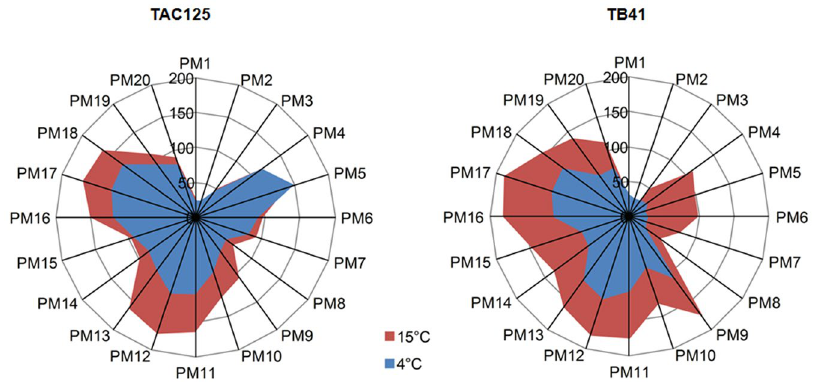
Figure 2. Phenotype Microarray (PM) experiment. Radar plots representing the number of the different growth phenotypes of the PhTAC125 and PspTB41 strains as assessed by the PM experiment at 4 °C (blue) and 15 °C (red). Each radial strip corresponds to a single PM microplate (PM1-20). PM categories: Carbon Sources (PM1, PM2), Nitrogen Sources (PM3), Phosphorus and Sulfur Sources (PM4), Nutrient Supplements (PM5), Peptide Nitrogen sources (PM6, PM7, PM8), Osmolytes (PM9), pH (PM10) and Chemicals